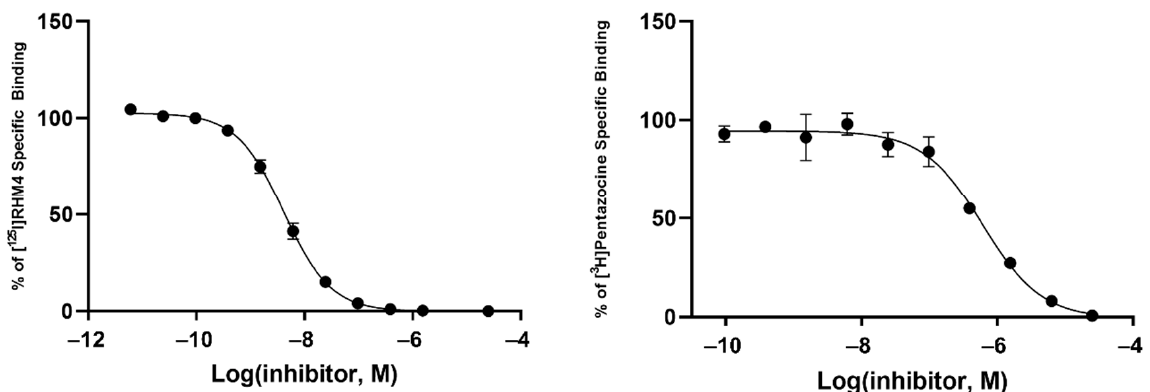
Figure 2. Representative binding curves of compound 2t for σ 2R ( left ) and σ 1R ( right ).